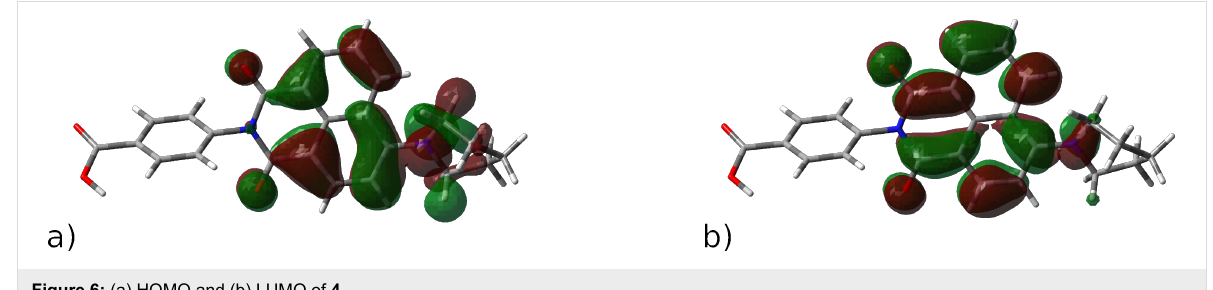
Figure 6: (a) HOMO and (b) LUMO of 4 .